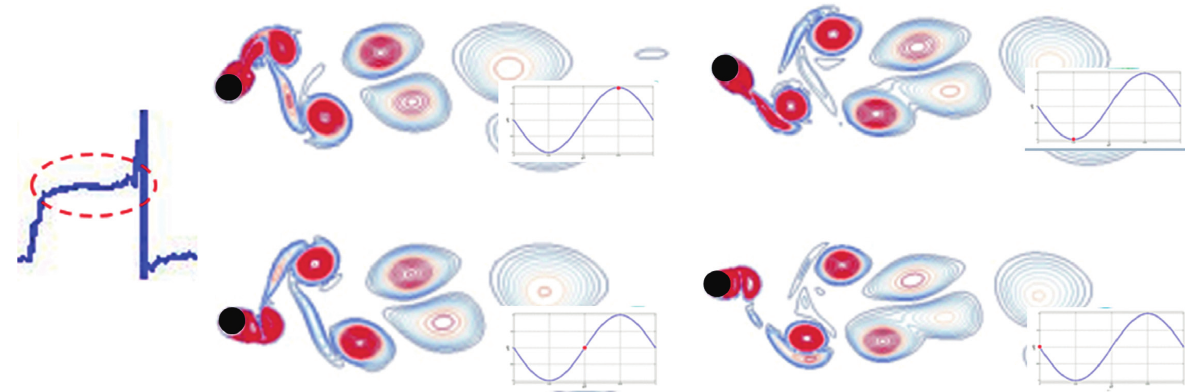
Figure 7: Phase angle at different amplitude ratios varying from 0.5 to